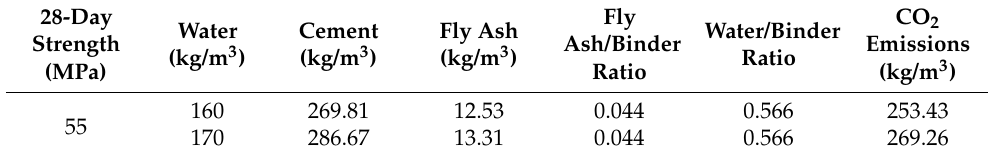
Table 3. Optimal results for low-CO 2 concrete of example 3. (CO 2 emission of fly ash of 0.2